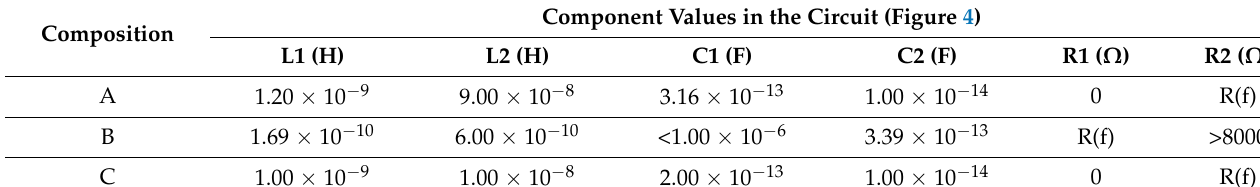
Table 3. Component values of the lumped-element circuit (Figure 4) for scaffold composites of Wangi rice starch and nHA at Ku-band.